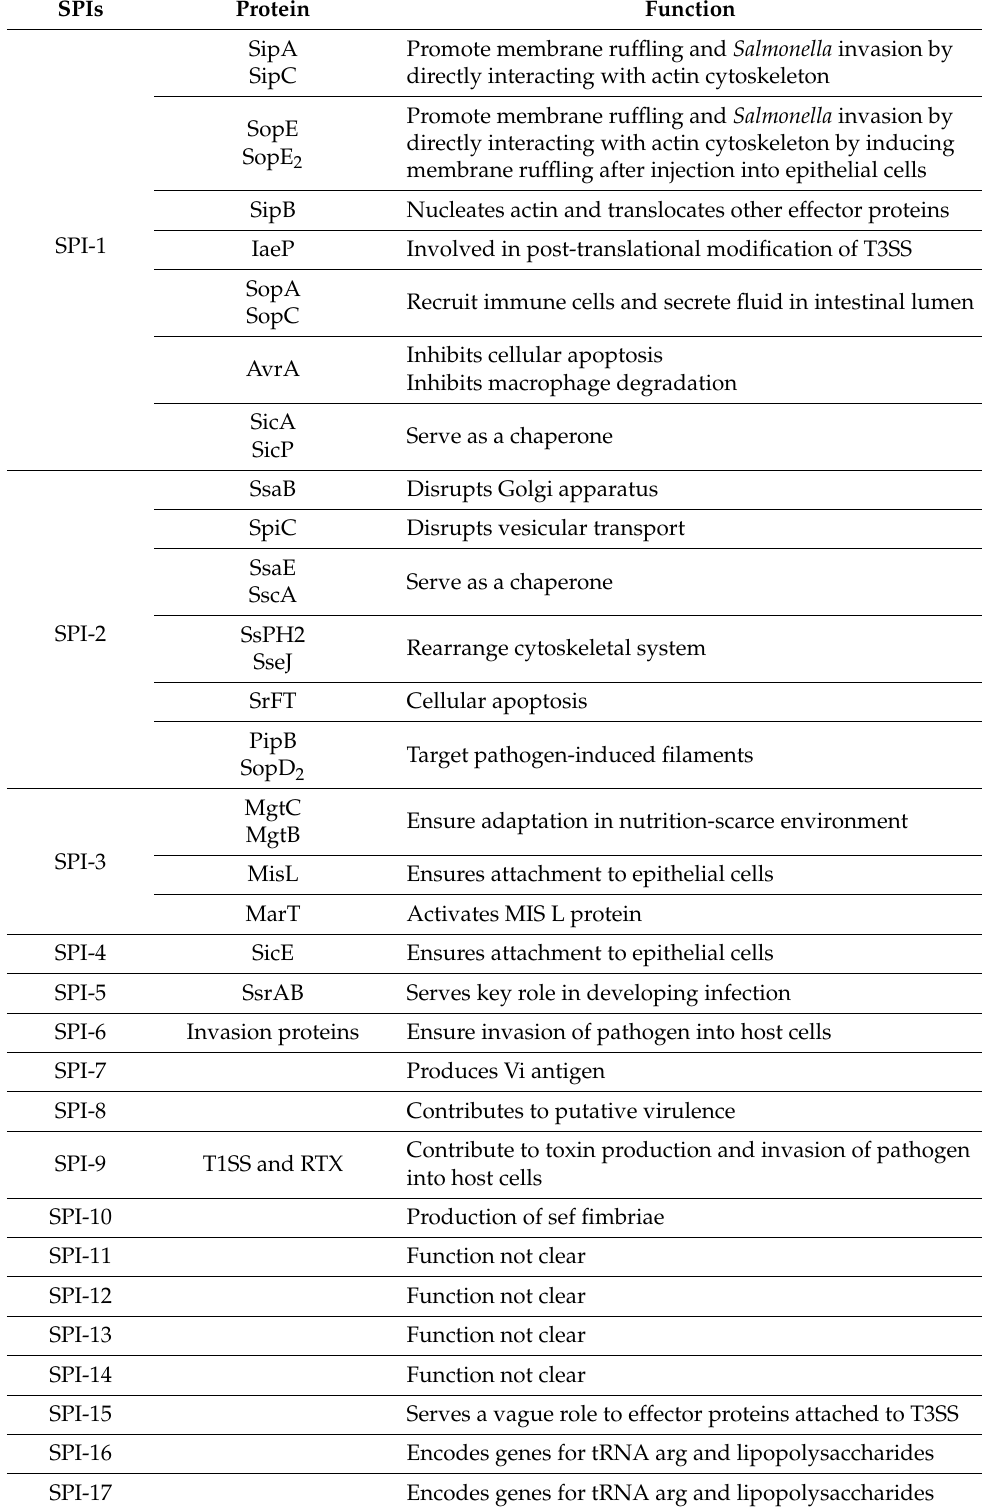
Table 1. Description of major Salmonella pathogenicity islands (SPIs) and their associated effector